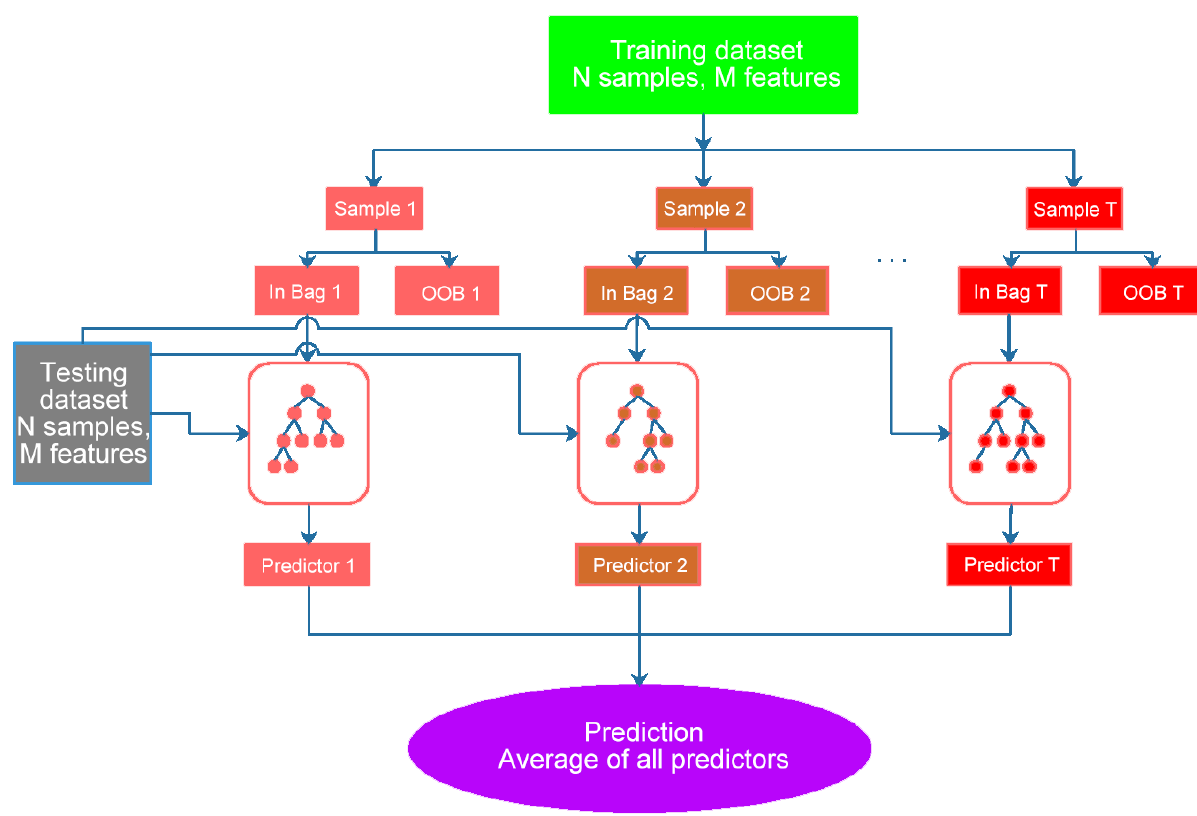
Figure 2. The flow chart of the RF algorithm.